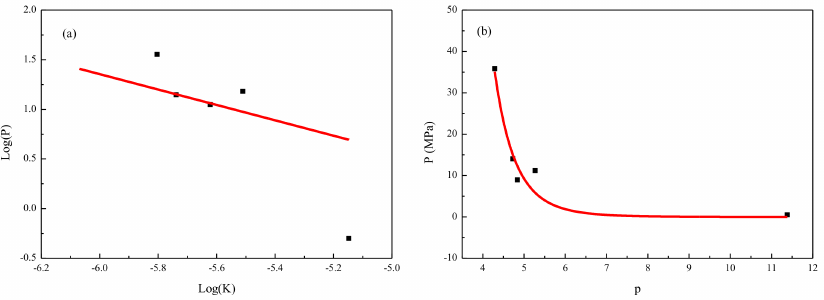
Figure 7. ( a ) The relationship between permeability and breakthrough pressure; ( b ) the relationship between permeability and